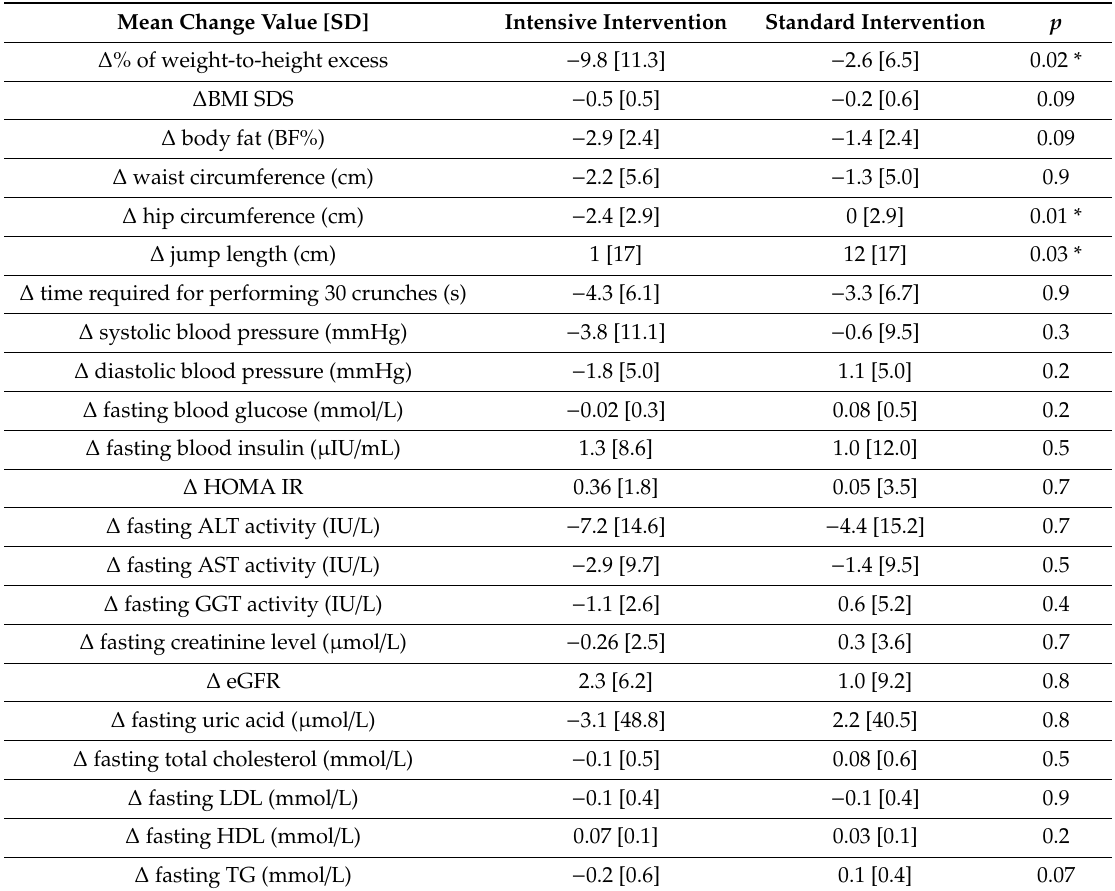
Table 1. Comparison of the results of intensive intervention and standard intervention. ∆ —change of the parameter value during the